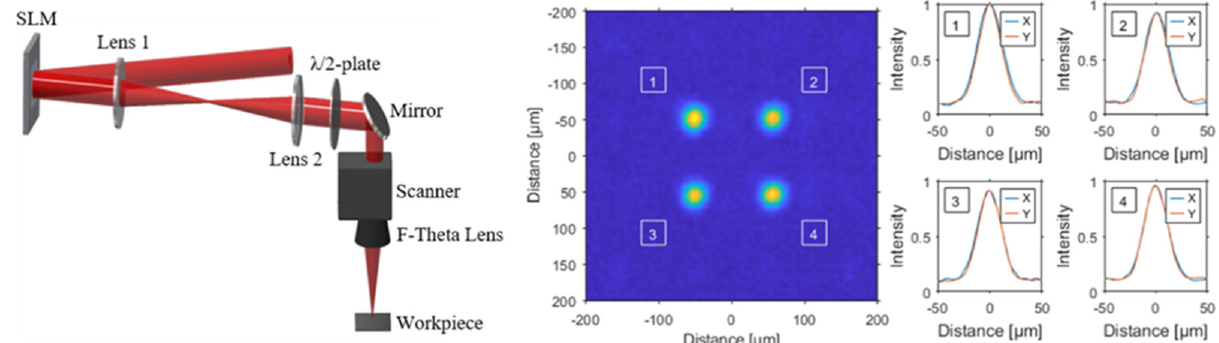
Figure 1. A schematic illustration of the setup for femtosecond laser ablation using a spatial light modulator (SLM) and a 4f-telescope with a galvo scanner including an F-Theta lens. Shown also are the measured intensity profiles of the four spots with a separation of 100 µm.